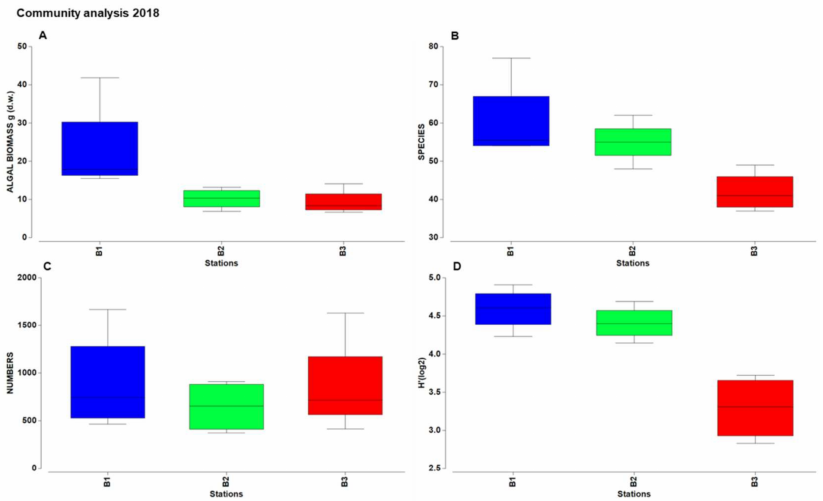
Figure 3. Trend of: ( A ) algal ( Cystoseira brachycarpa ) biomass (g d.w.); ( B ) number of species; ( C ) num- ber of individuals; ( D ) H’ diversity index of benthic invertebrates off the Bottaro crater vent at the three studied stations (B1, B2, and B3) in September